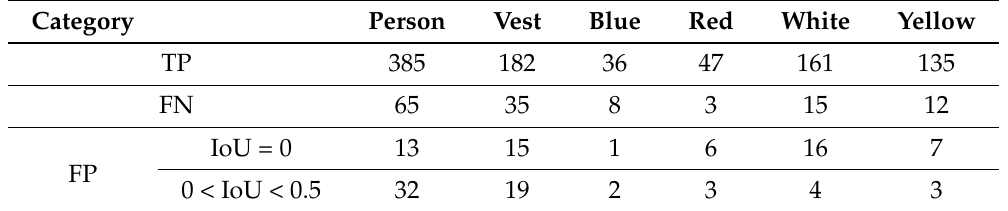
Table 7. YOLO v5x confusion